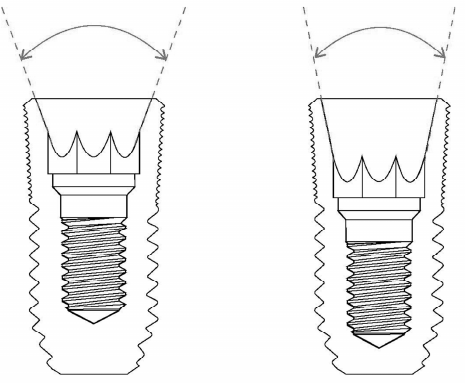
Figure 1. The degree of conical connection. A wider tapering angle (left) results in a more unstable connection for abutment mobility in internal connection-type implants.